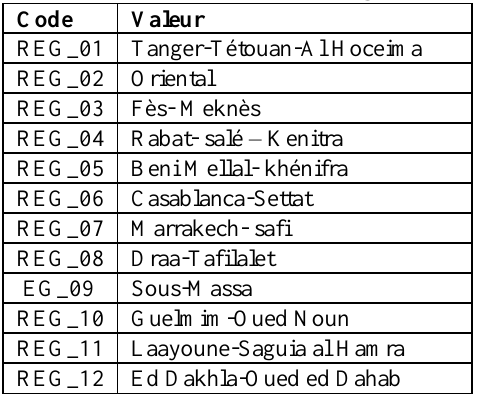
Table 2: Lexicon table: